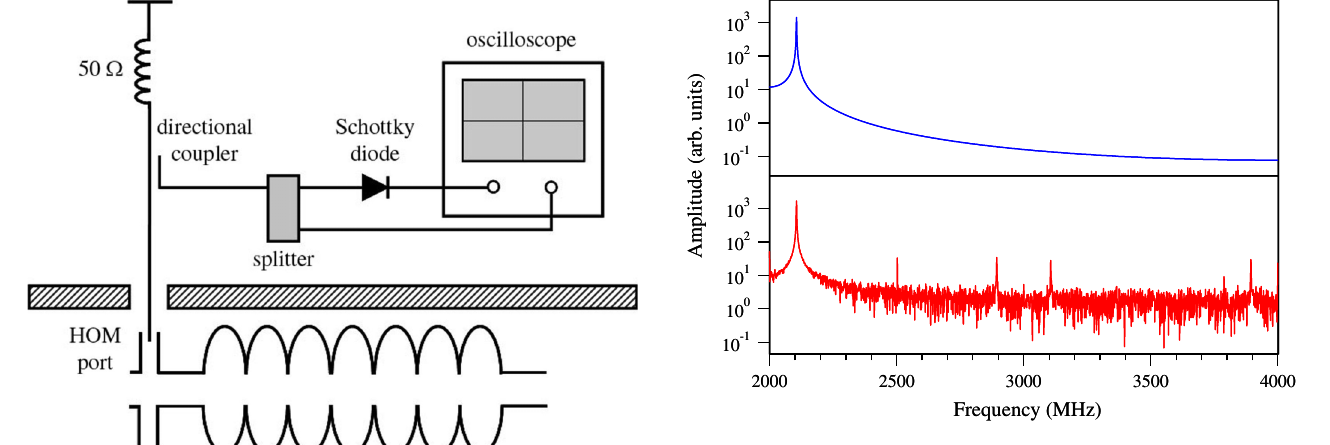
FIG. 3. (Color) FFT of a pure 2106.007 MHz signal (top) and FFT of the HOM voltage from cavity 7 during BBU (bottom). FIG. 1. Schematic of the experimental setup for simulta-